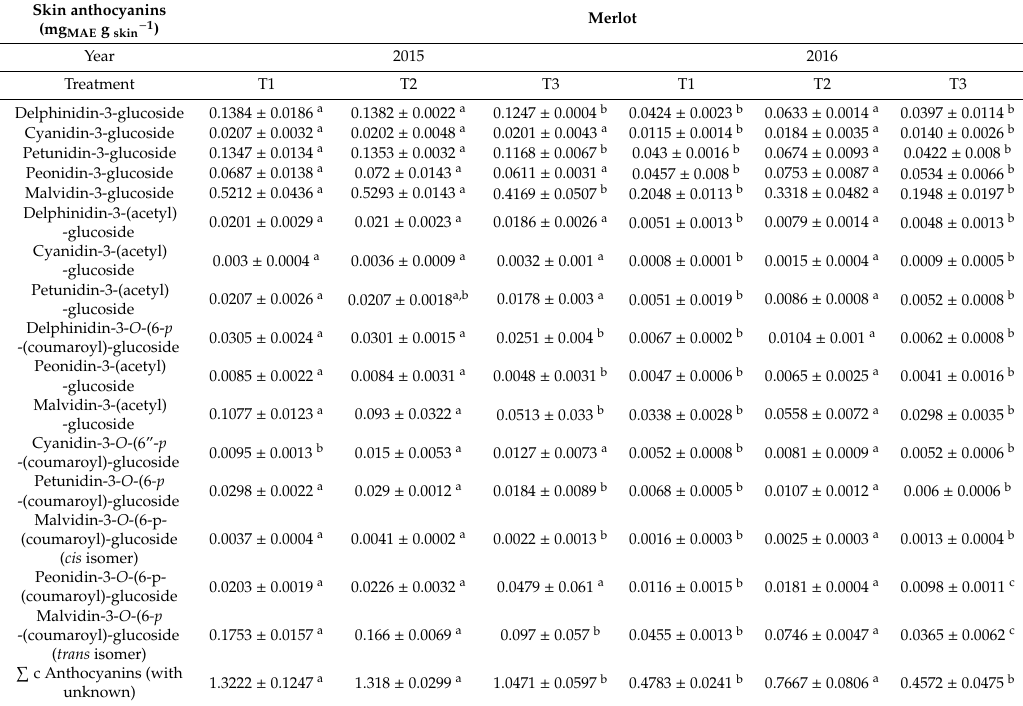
Di ff erent superscript lower case letters in each row indicate statistically significant di ff erences ( p < 0.001) between